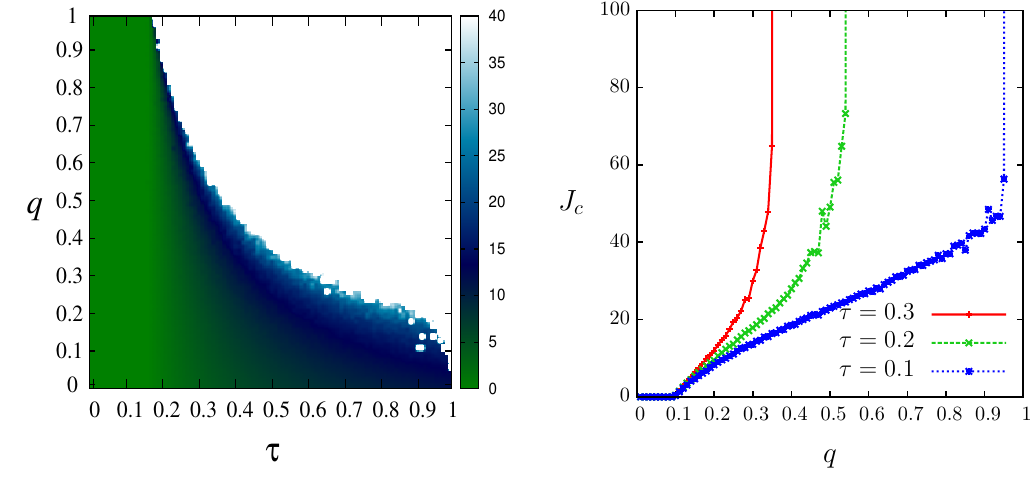
Figure 15. ( Left ) Critical precaution threshold J c (gray/color code) as a function of the bare infection τ and of the difference q between the physical and the information network. Here, the physical and = 6 and N = 1000. In the darker region, there is k virtual networks are Poissonian (random) with (cid:104) (cid:105) always a value of J c able to stop the epidemics, while in the white region the epidemics cannot be stopped. The separation boundary is the “stoppability” frontier. ( Right ) Critical precaution threshold J c versus the difference between the physical and the information network q for some values of the bare infection τ (from right to left τ = 0.1,0.2,0.3). Random physical network and scale-free virtual = 6, N = 10,000. Figures from k network, both with (cid:104) (cid:105)